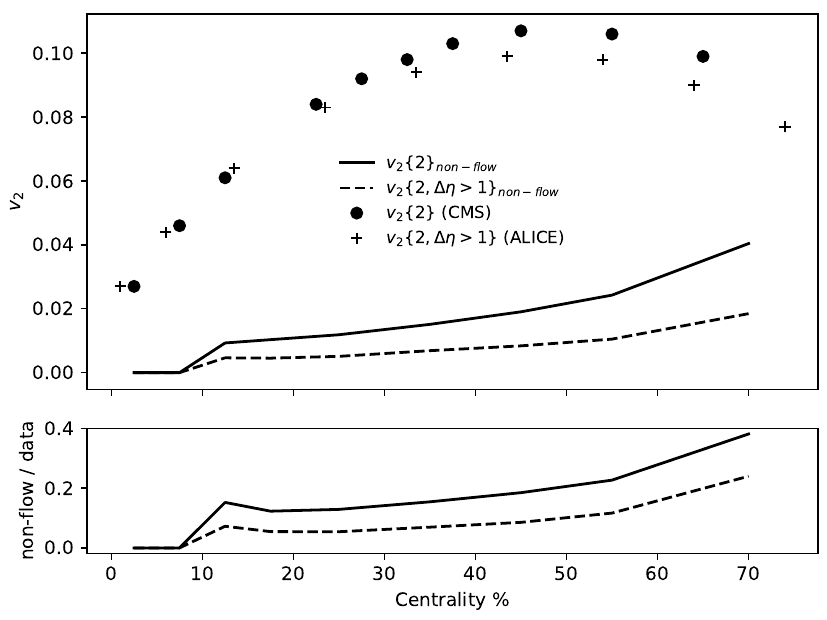
Figure 20 . The elliptic (cid:13)ow coe(cid:14)cient v 2 (without (cid:1) (cid:17) -gap) and ALICE [64, 65] (with (cid:1) (cid:17) = 1), compared to the non-(cid:13)ow contribution calculated by Angantyr. In the ratio plot it is seen that the non-(cid:13)ow contribution without (cid:1) (cid:17) -gap is nearly 40%. This is reduced to 20% when applying a